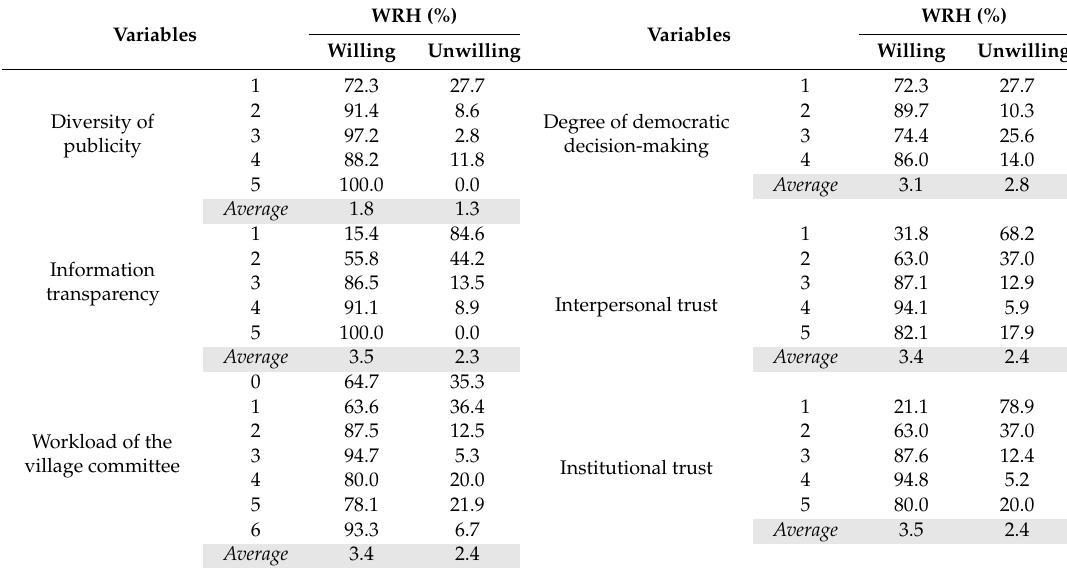
Table 3. Farmers’ willingness of WRH with the participation of village